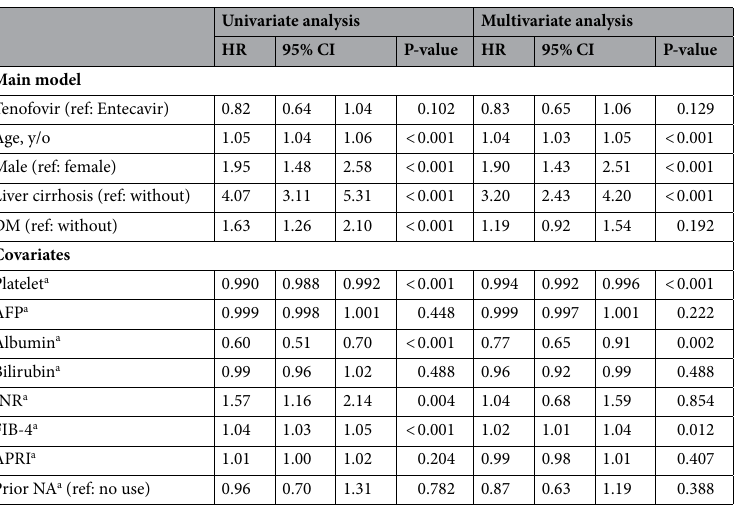
Table 3. Risk factors for HCC in PS matched cohort. PS propensity score, HR hazard ratio, CT confidence interval, DM diabetes mellitus, AFP alpha-fetoprotein, INR international normalized ratio, FIB-4 fibrosis index based on 4 factors, APRI AST to platelet ratio index, NA nucleos(t)ide analogue. a Adjusted for tenofovir, sex, age, liver cirrhosis,